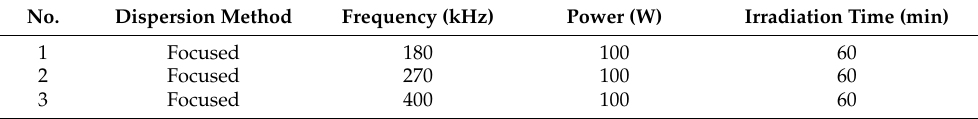
Table 3. Operating conditions for ultrasonic emulsification at different frequencies.